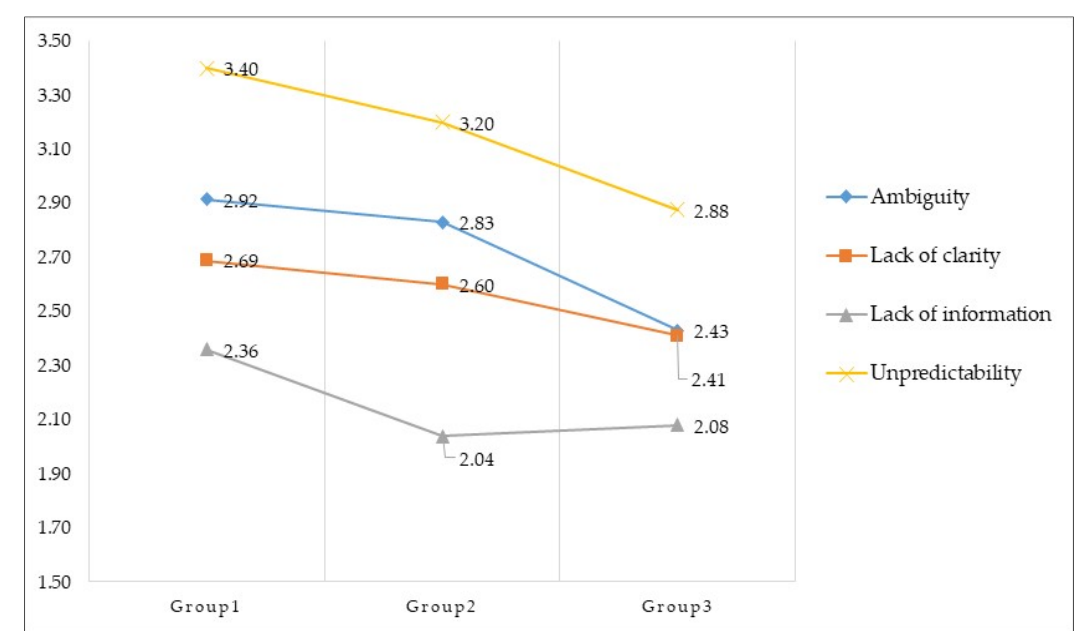
Figure 1. Uncertainty comparison according to treatment phase across four subdomains. Group 1 = treatment initiation phase; Group 2 = ongoing treatment phase; Group 3 = post-treatment phase. Table 4. Scores for each item on PPKS-FM scale across the treatment